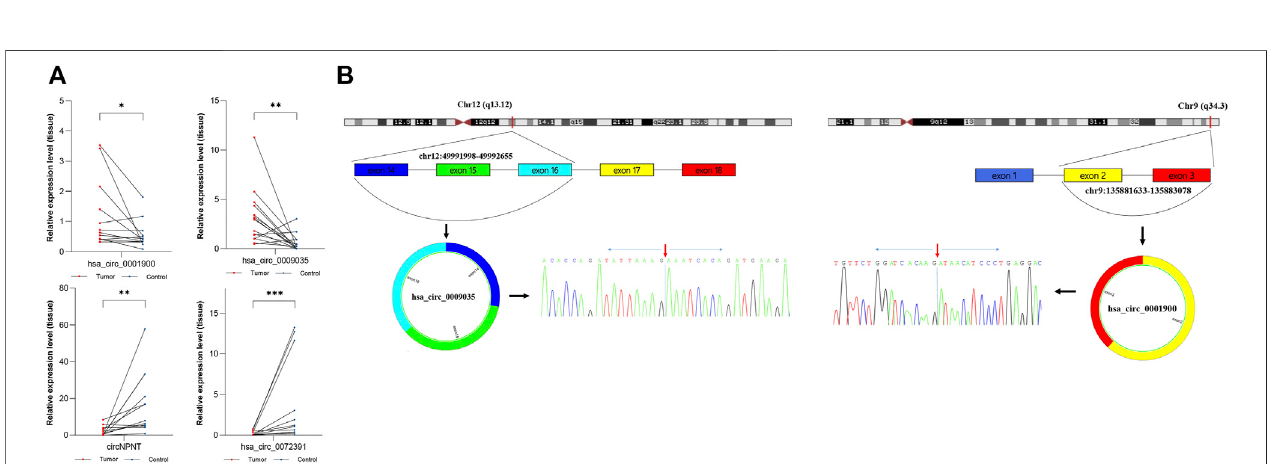
FIGURE3| Veri fi cation ofdysregulatedcircRNAs. (A) Expressionlevelofhsa_circ_0001900, hsa_circ_0009035,circNPNT, andhsa_circ_0072391.Results were analyzed by paired t -test.*: p < 0.05, **: p < 0.01, ***: p < 0.001. (B) The genomic loci of hsa_circ_0001900 or hsa_circ_0009035 and schematic representation of their formation.Theexpressionofhsa_circ_0001900orhsa_circ_0009035wasvalidatedbyqRT-PCRusingaspanningjunctionprimerfollowedbySangersequencing.The red arrow represents head-to-tail splicing